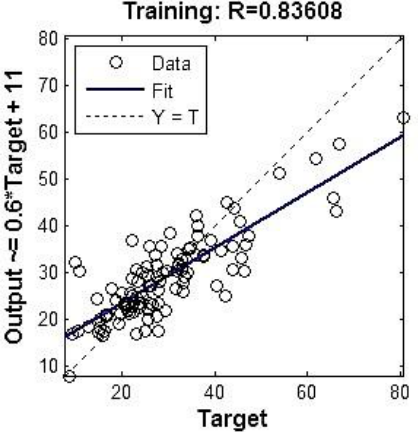
Fig. 10. Relationship between Target and Output Values in Training Step of ANN Modeling with 5 Hidden Neurons.